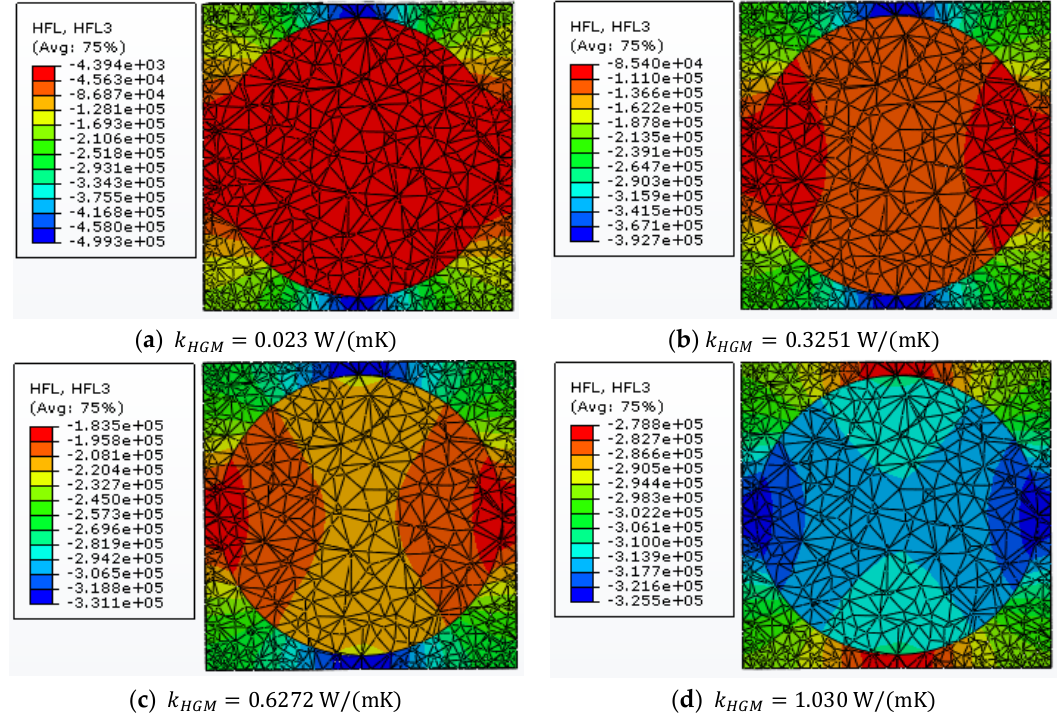
Figure 14. Variations of heat flux component q z along the z direction in the two-phase composite unit cell with 20% microsphere volume fraction.